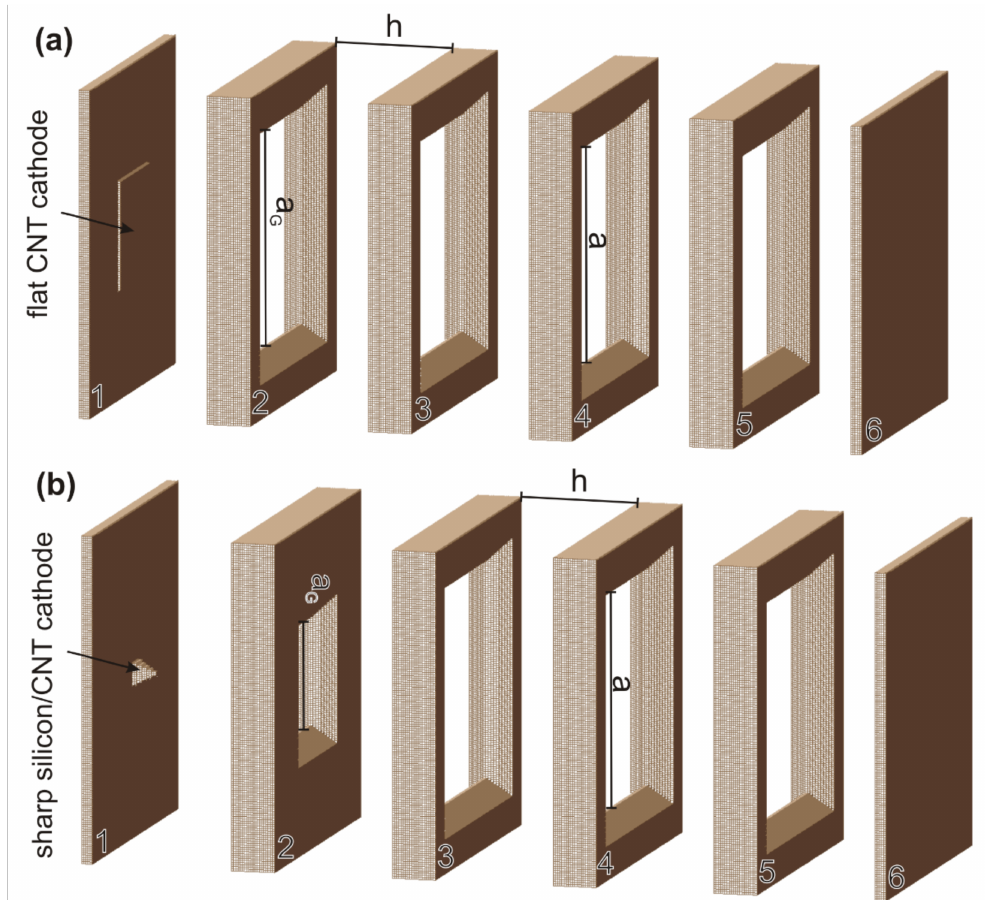
Figure 2. Examples of microcolumn model applied in SIMION 3D v.7.0 software: ( a ) flat CNT cathode model a = a G = 2 mm; ( b ) sharp silicon/CNT cathode model a = 2 mm, a G = 1 mm (1—cathode, 2—gate, 3, 4, 5—Einzel lens,